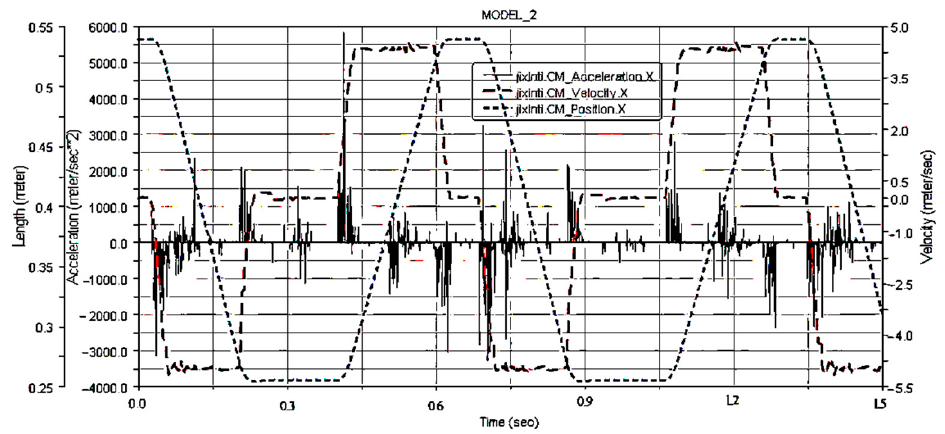
Figure 15. The change in the contact force vs. time without clearance and recoil. The contact force between the main roller and the fixed cam curve slot is shown in Figure 15. Two dotted lines indicate the position and velocity of the mass center of the main roller, respectively. The black line indicates the variation in the acceleration of the mass center of the main roller with time t under no recoil. The maximum acceleration value is below 5000 m/s 2 except for the point at 0.406 s, and the motion period is 0.605 s. With the clearance and under no recoil, the main roller motion is illustrated in Figure 16. The movement of the Gatling bolt body is illustrated in Figure 17. The time is extended to 1.5 s to observe the change in bolt acceleration. The clearance influences the system transmission in Figure 18. Figure 16. The bolt body motion of clearance and recoil. Figure 17. The bolt body motion without recoil and with a 0.1 mm gap.